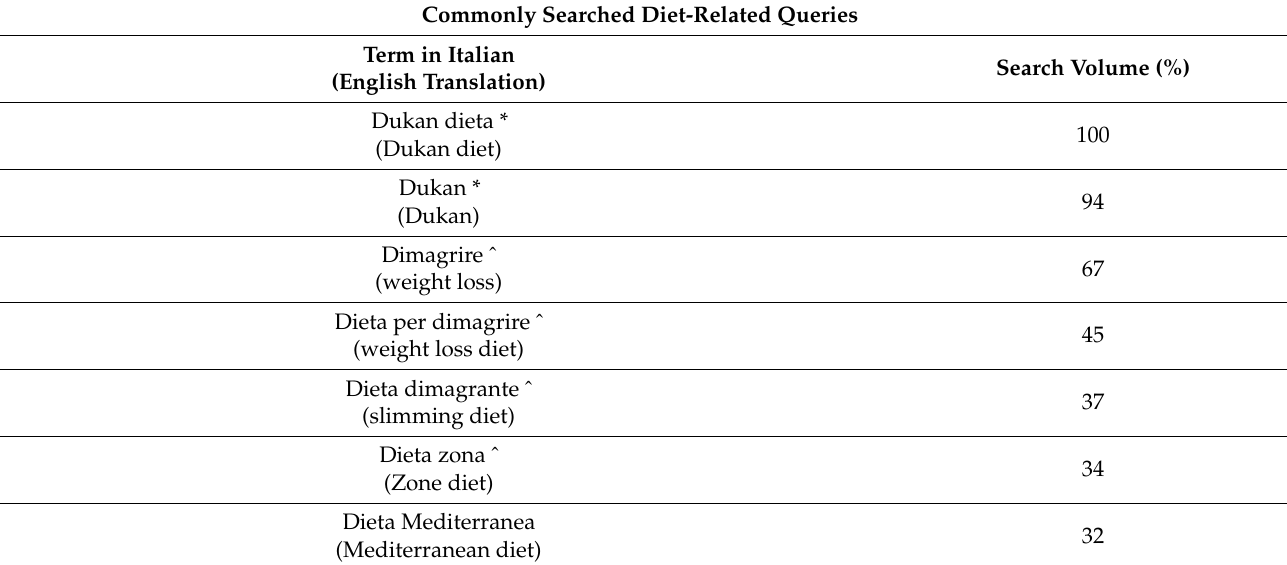
Table 2. Diet-related queries in the study period (2004–2021) using Google